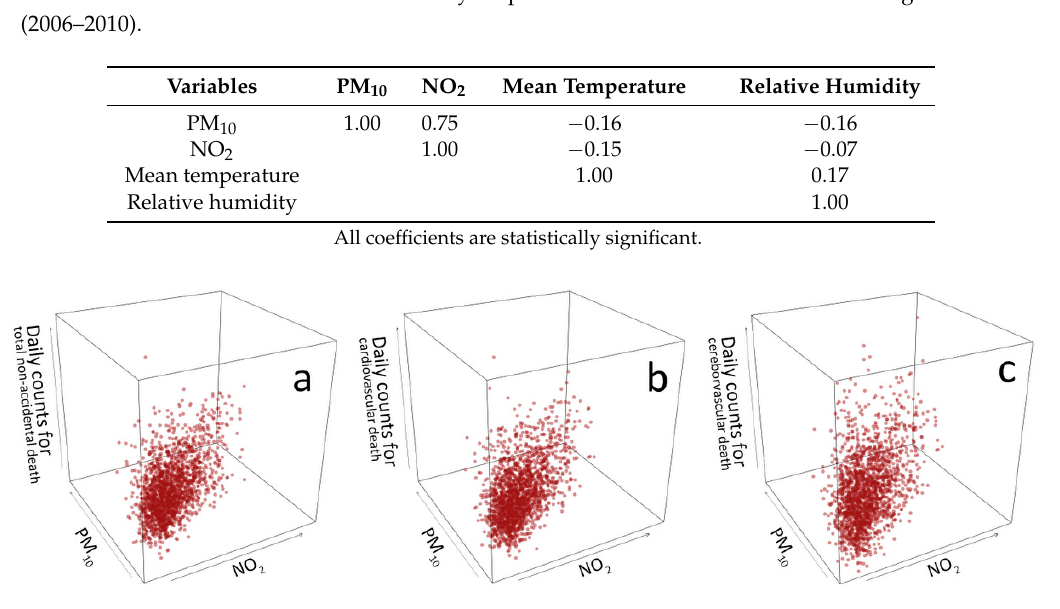
Figure 2. Three ‐ dimension scatter plots of daily PM 10 , NO 2 and mortality (2006–2010). This figure displays the correlation between daily PM 10 concentrations, daily NO 2 concentrations and daily non ‐ accidental death counts in a three ‐ dimensional way. The subplots a, b and c in this figure are the scatter plots between air pollution concentrations and three subsets of mortality (non ‐ accidental death, cardiovascular death and cerebrovascular death), respectively.